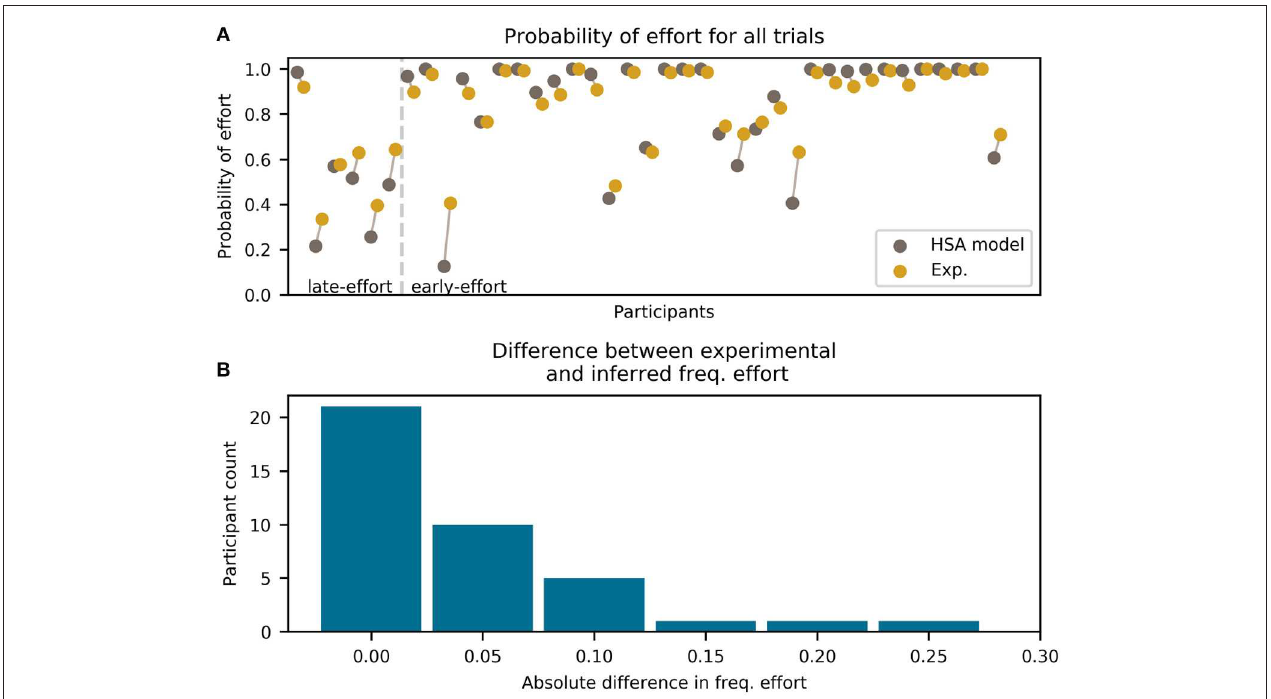
FIGURE 5 | Frequency of effort for each participant (excluding the all-effort group) and the HSA model (hyperbolic discounting applied to the “effort:stack/probability: add” model variant). Only trials before winning the mini-block are included. (A) For each participant, two colored dots are shown, which represent the experimental data (green) and the model prediction (brown). Each dot represents the total frequency of effort for the whole experiment. The two dots for each participant are horizontally offset and connected by a line for visual clarity. Participants are divided by the vertical dashed line into late-effort and early-effort. (B) Histogram of absolute error between the model and the experimental frequency of error shown in (A)